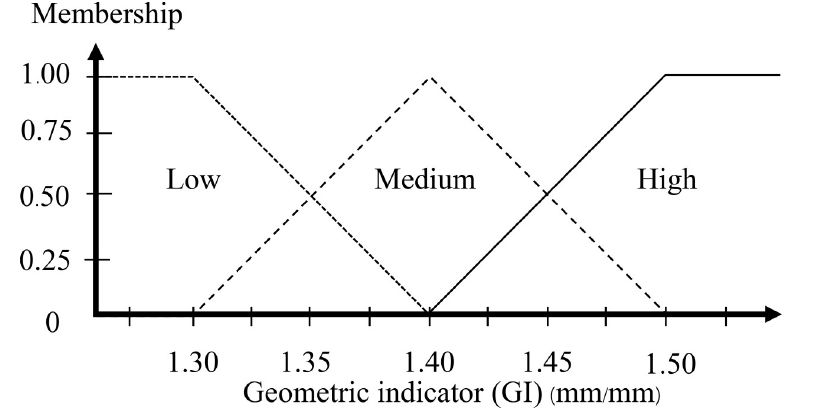
Fig 8. Input membership functions of the geometric indicator.